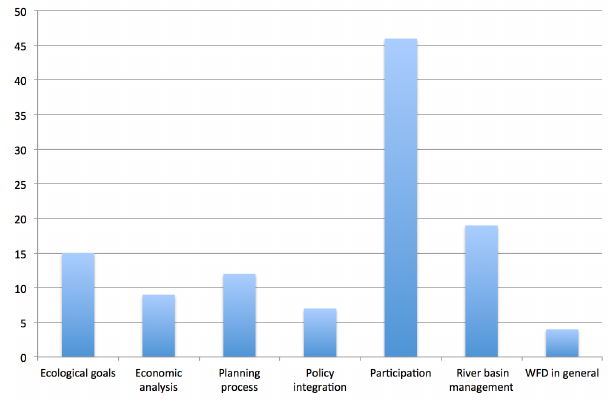
Fig. 5 . Number of studies per WFD theme. WFD indicates Water Framework